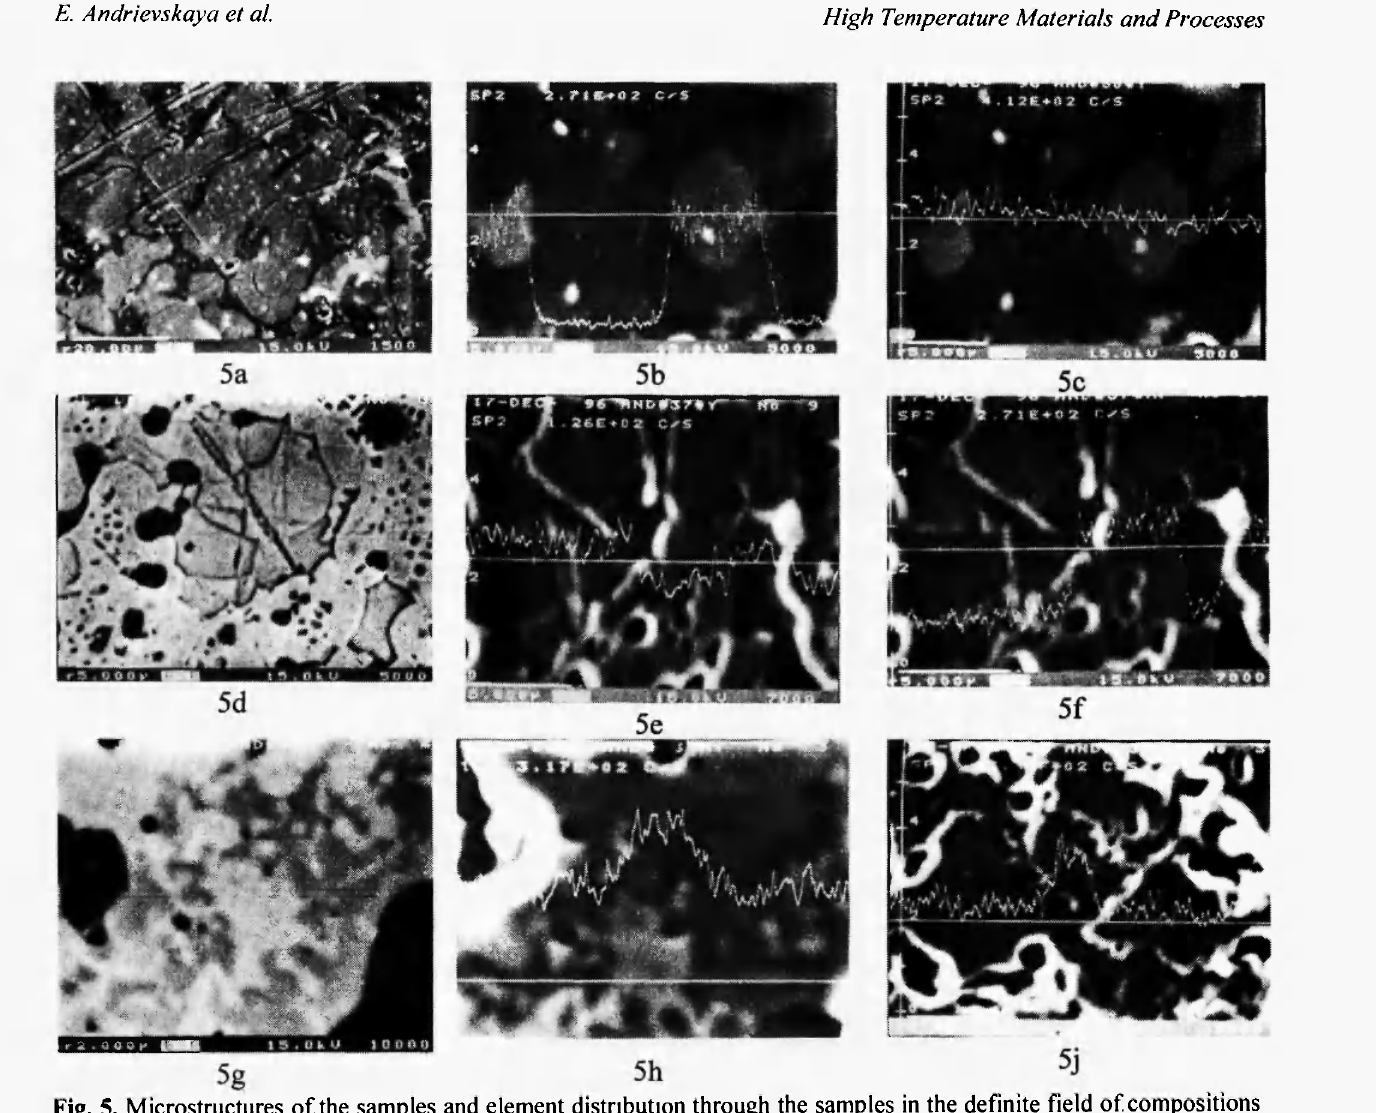
Fig. 5. Microstructures of the samples and element distribution through the samples in the definite field of compositions of the sub-system Sm 2 0 3 - Sm 2 Hf 2 0 7 -Y 2 0 3 heat-treated at 1600 °C: (a) <B>+<C>, light is <C-Y 2 0 3 >, gray